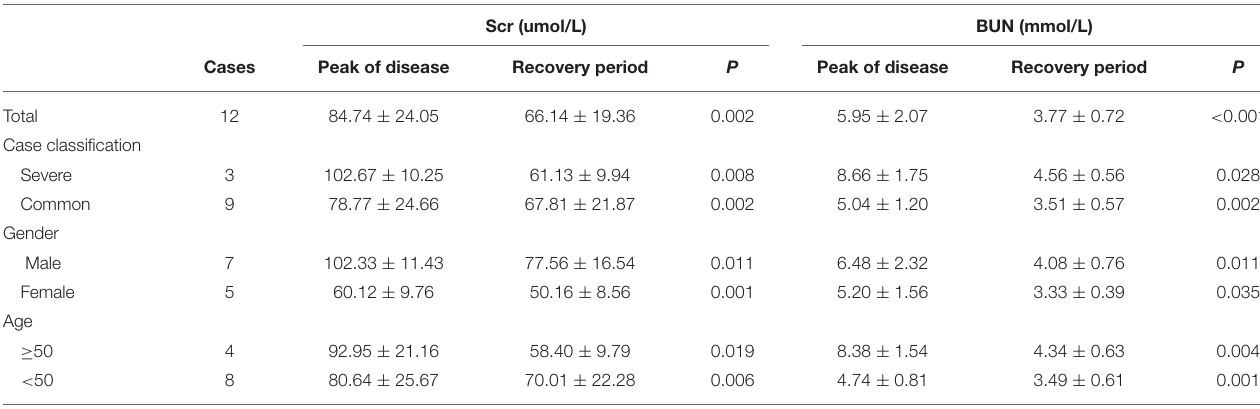
TABLE 2 | Comparison of Scr and BUN between peak of disease and recovery